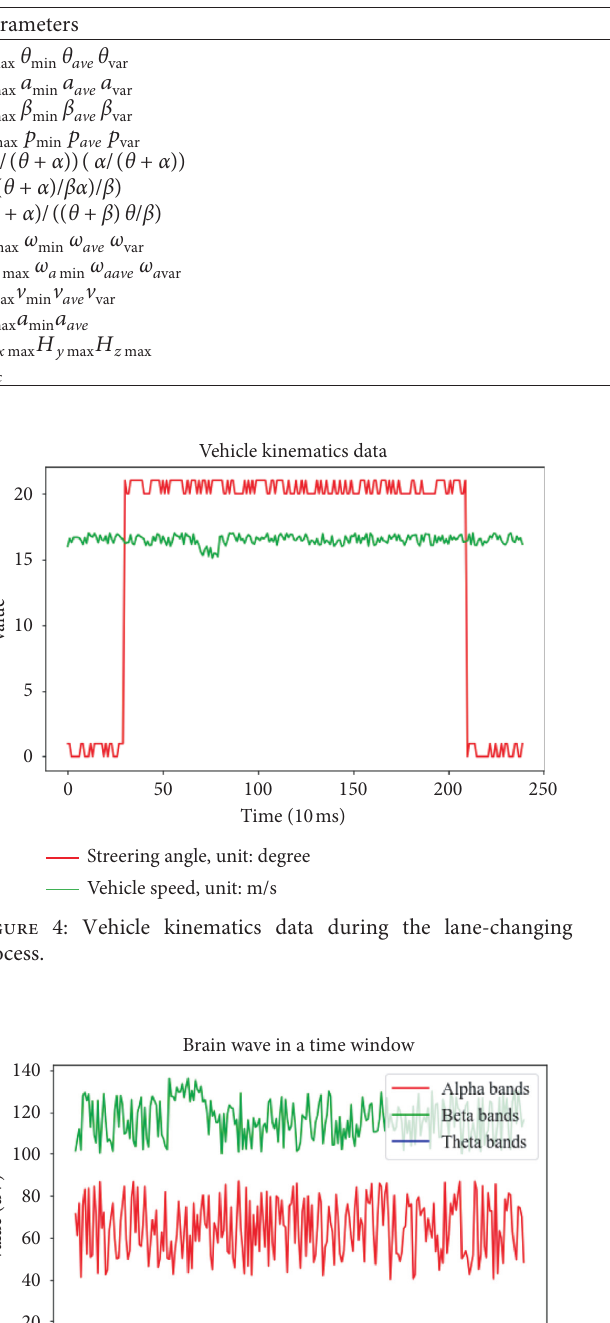
Table 2: The extracted features and labels.